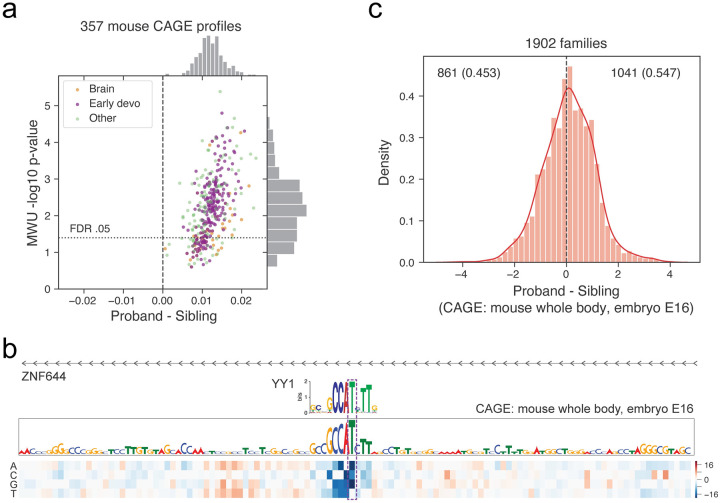
Human de novo variant predictions for mouse data enrich for autism probands versus their siblings.(a) We predicted the influence of 234k de novo variants split between probands and sibling controls on 357 CAGE datasets in mouse. For each dataset, we computed a Mann-Whitney U (MWU) test between proband and sibling sets and corrected for multiple hypotheses using the Benjamini-Hochberg procedure. Predictions for many datasets were enriched for greater values in the probands, driven largely by early developmental profiles. Each dataset’s x-axis position is the mean natural log over proband variants minus the equivalent over control variants. (b) A proband variant at chr1:91021795 modifies a critical T in a YY1 motif to an A in the promoter region of ZNF644. (c) At the individual level, a simple score summing variant predictions for a leading developmental dataset describing mouse CAGE whole body at embryonic stage E16 significantly separates probands from their matched sibling controls (binomial test p-value 2 × 10−5).